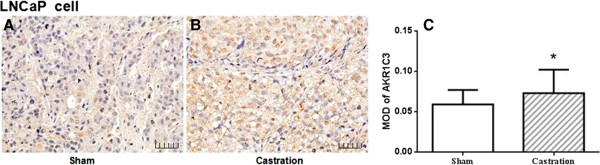
Immunohistochemical expression of AKR1C3 in LNCaP xenograft mouse models with or without castration. (A) LNCaP-sham. (B) LNCaP + castration. (C) MOD of AKR1C3 in LNCaP xenograft mouse models. *P < 0.05, compared with sham group. Scale bar is 50 μm.